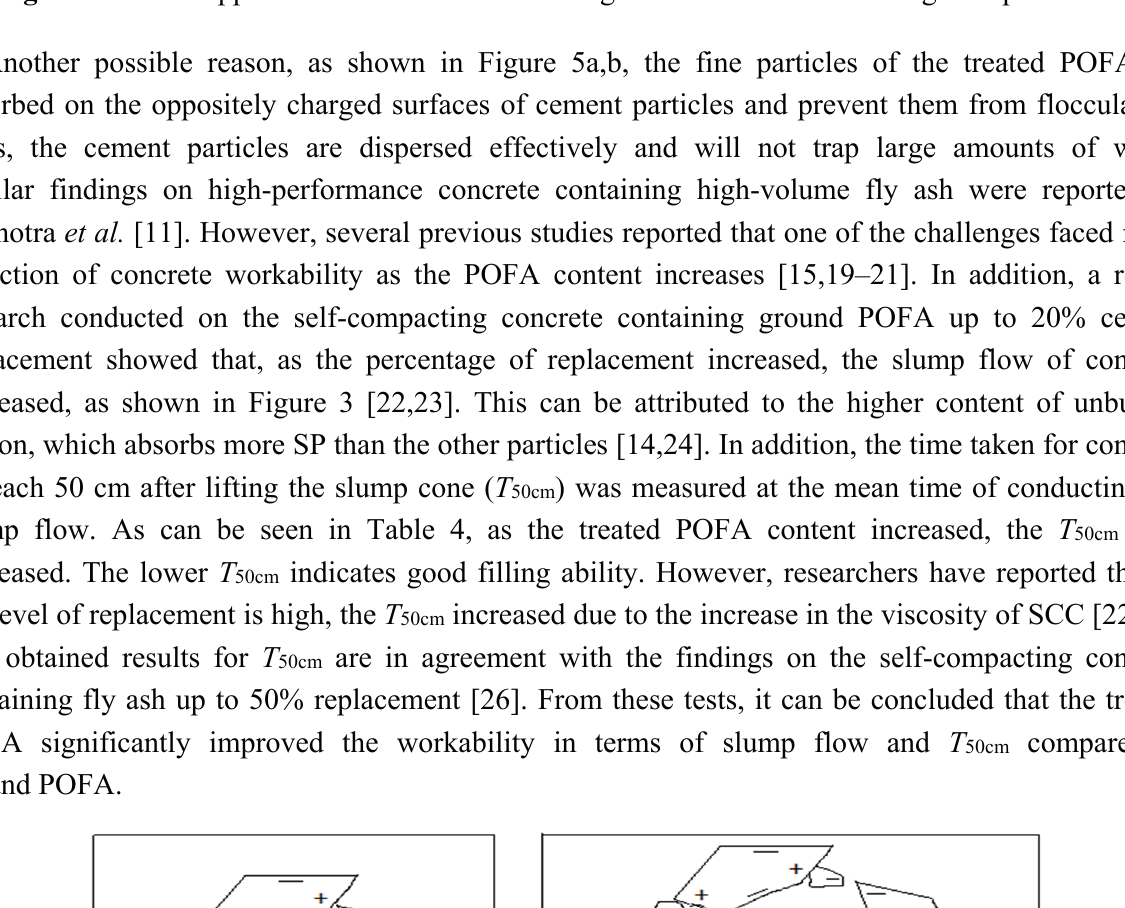
Figure 4. Visual appearance of concrete containing 50% treated POFA during slump flow test.